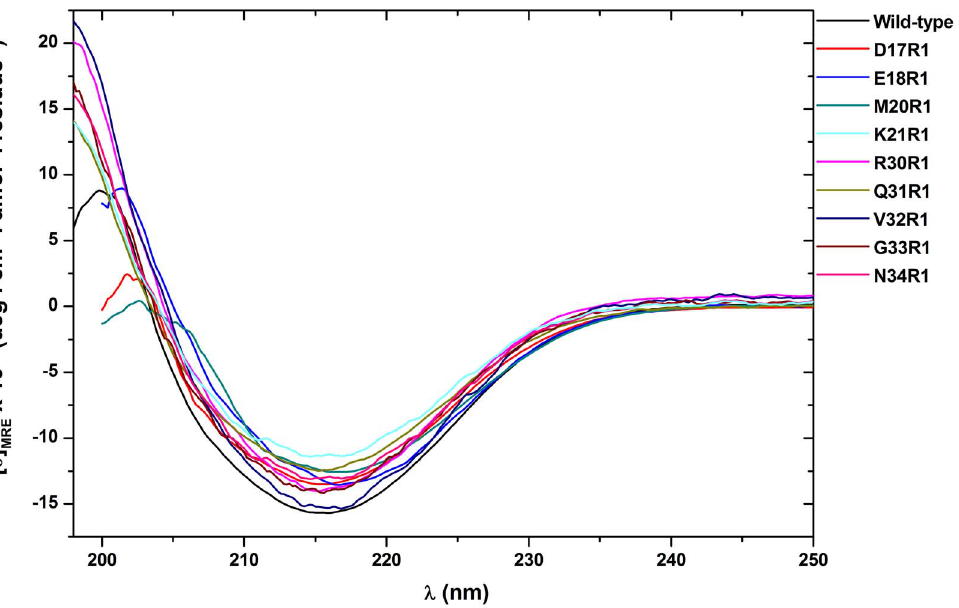
Figure 2. CD spectra of B-FABP wild type and their mutants in 20 mM phosphate buffer (pH 8.0). All spectra are characterized by a negative minimum around 215 nm, which is typical in b -rich proteins. The similarity of the spectra suggests that the introduction of the Cys residue in the mutants of B-FABP has not significantly altered their overall secondary structure arrangement.